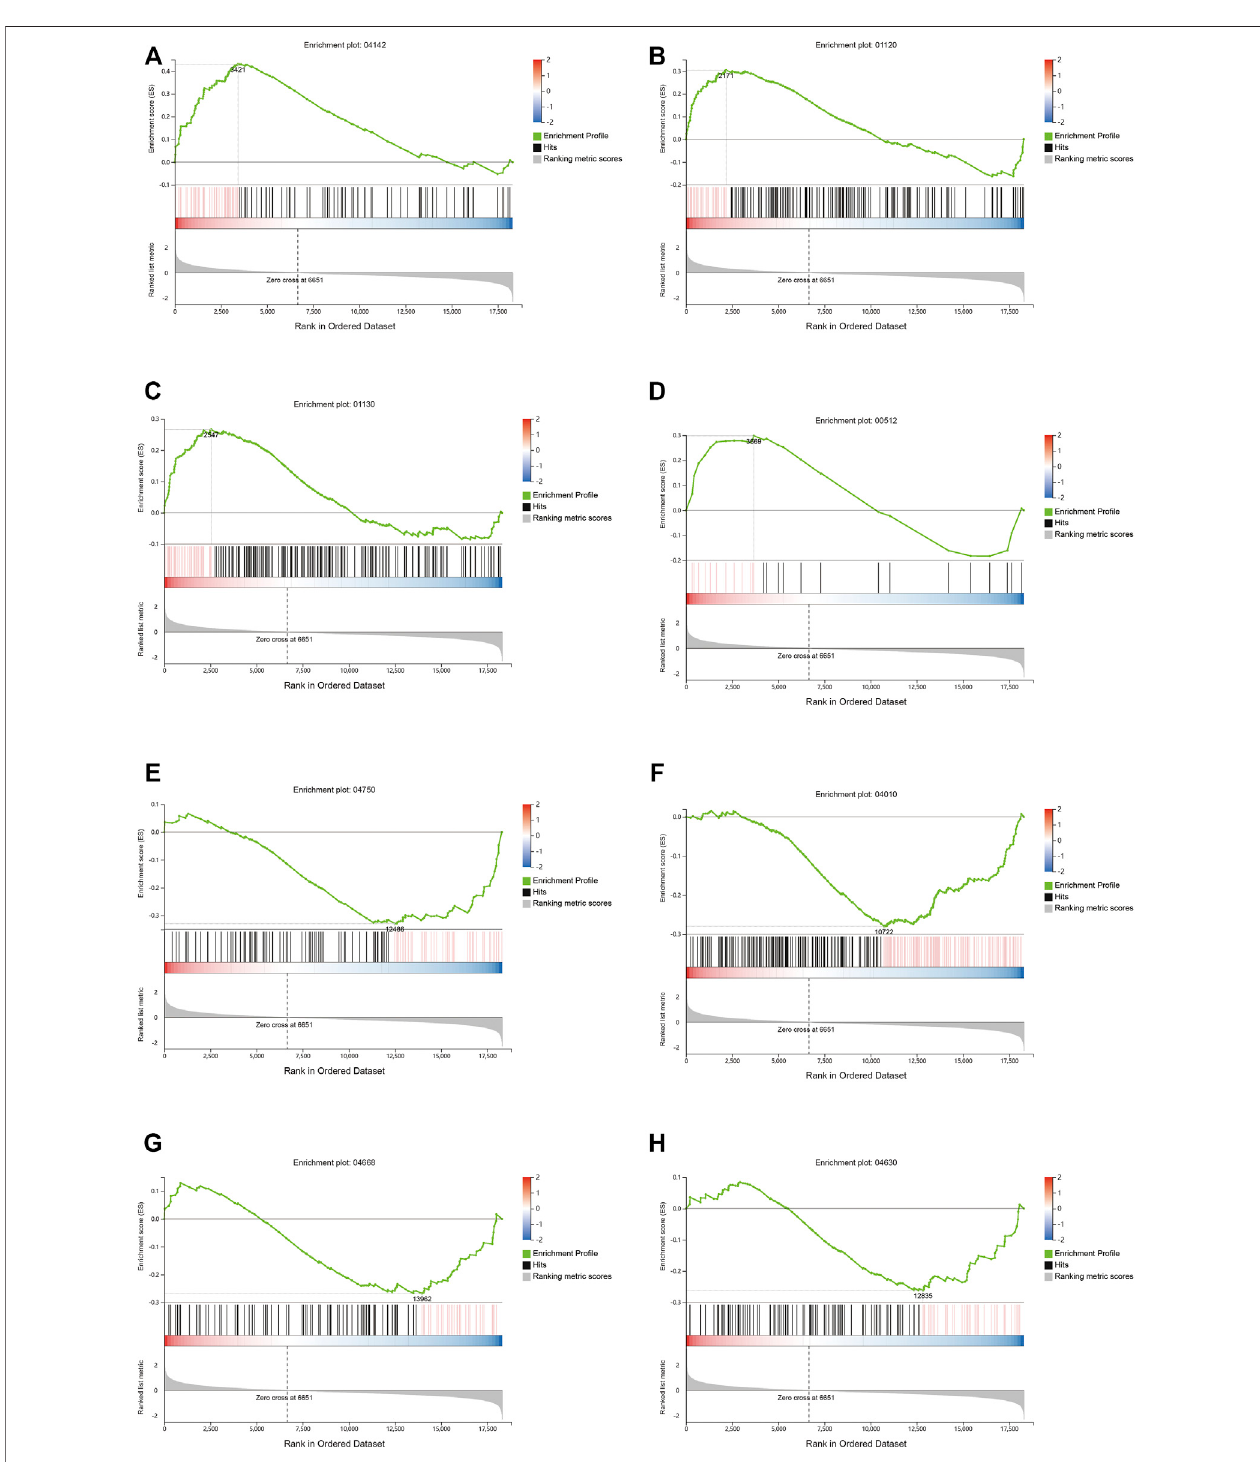
FIGURE 5 | Signaling pathway analysis by Gene Set Enrichment Analysis (GSEA). Upregulated pathways included lysosome (A) , microbial metabolism in diverse environments (B) ,biosynthesisofantibiotics (C) ,andmucintypeo-glycan biosynthesis (D) ,Downregulatedpathwaysincludedin fl ammatorymediatorregulationofTRP channels (E) , MAPK signaling pathway (F) , TNF α signaling pathway (G) , and Jak-STAT signaling pathway (H) .